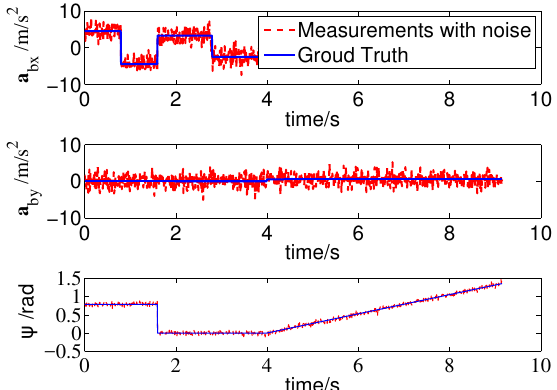
Figure 12. The true values and values with noise of inertial measurement unit (IMU) sensors.